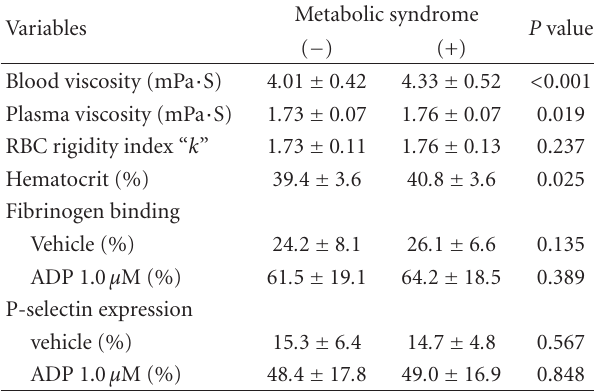
Table 2: Comparison of hemorheological variables, red blood cell (RBC) rigidity index “ k ”, hematocrit and platelet function between essential hypertensives with and without metabolic syndrome.